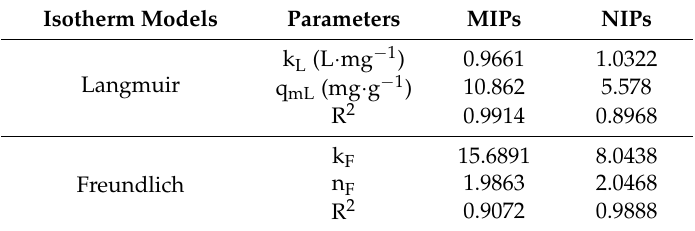
Table 3. Adsorption isothermal fitting parameters of MIPs and NIPs towards